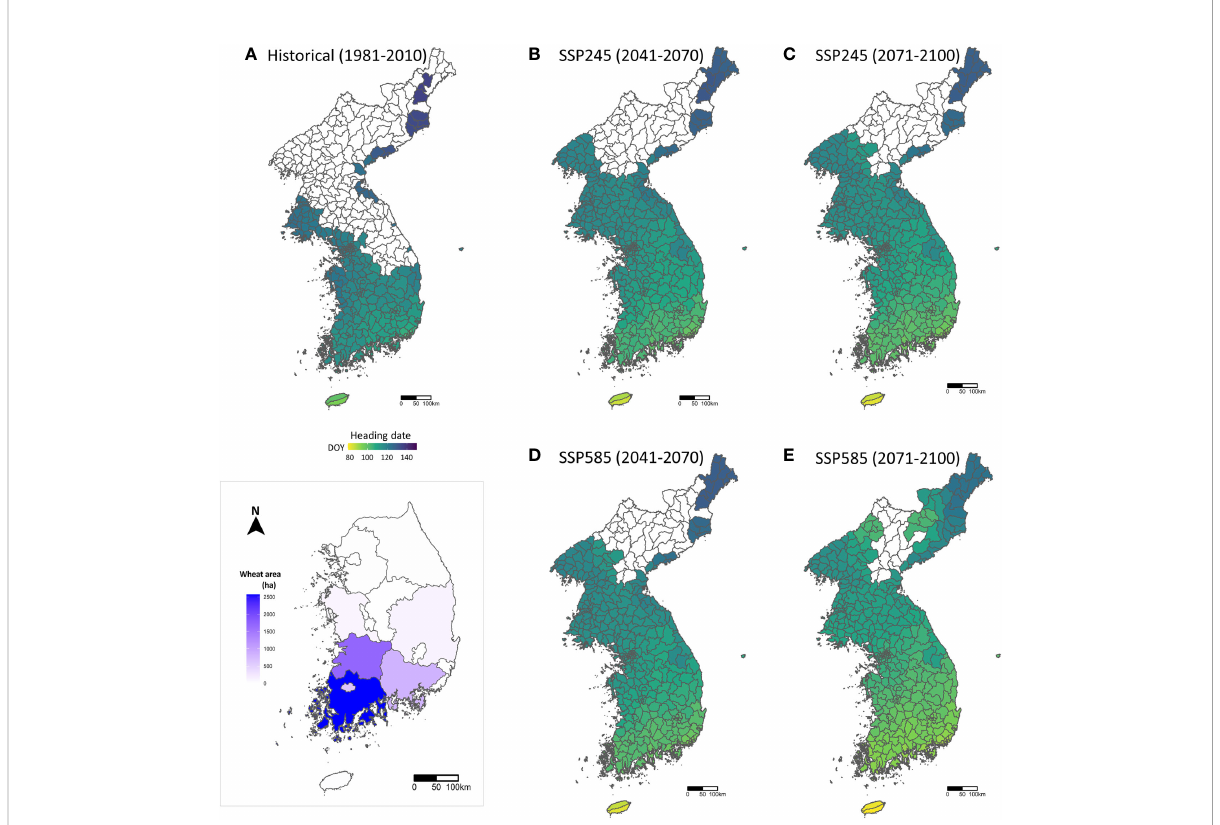
FIGURE 2 Areas suitable for wheat cultivation and the day of year (DOY) of the predicted heading dates on the maps of the Korean Peninsula in 1981-2010 (A) for the historical period, 2041 – 2070 (B) and 2071 – 2100 (C) under the SSP245 scenario, and 2041 – 2070 (D) and 2071 – 2100 (E) under the SSP585 scenario for the future periods. The colored areas indicate suitable wheat cultivation areas, and the DOY of the heading dates is expressed in color. The bottom left map (inset) shows the actual wheat cultivation areas (ha) in the provinces of South Korea for 2018 – 2022, obtained from the Korean Statistical Information Service